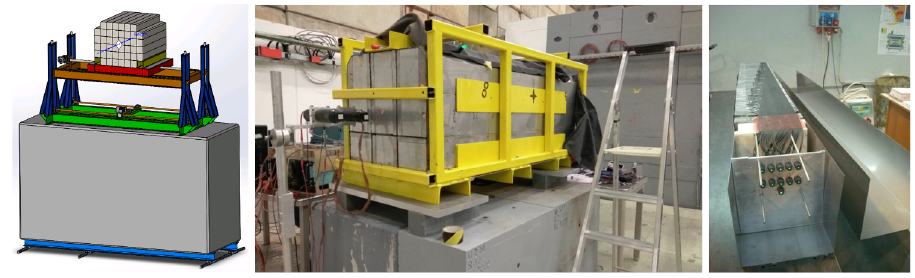
Figure 1. (Left) Design of PSD with a support platform [2]. (Center) PSD supermodule. (Right) PSD module during assembly